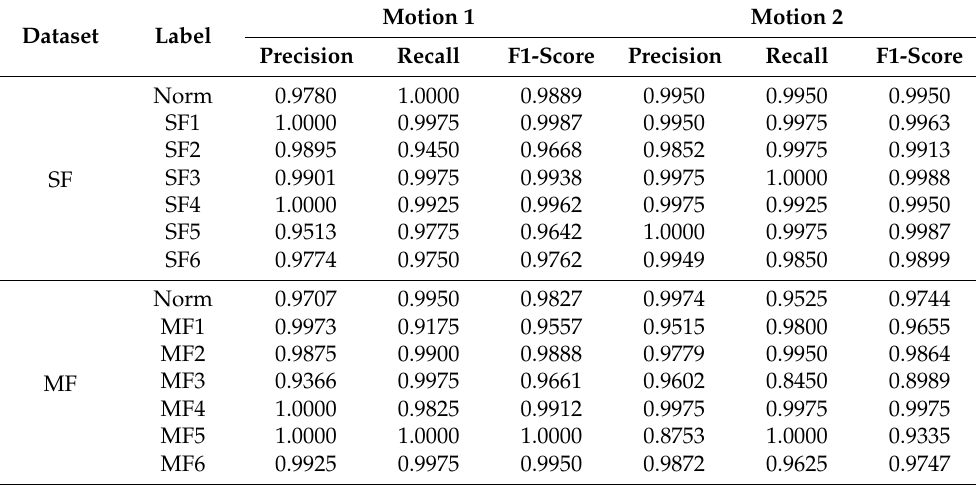
Table 5. The recognition results of LSTM on SF and MF